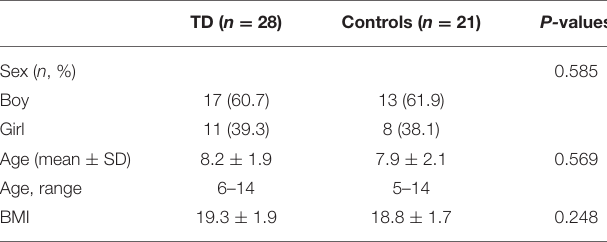
TABLE 1 | Characteristics of patients with TD and healthy control